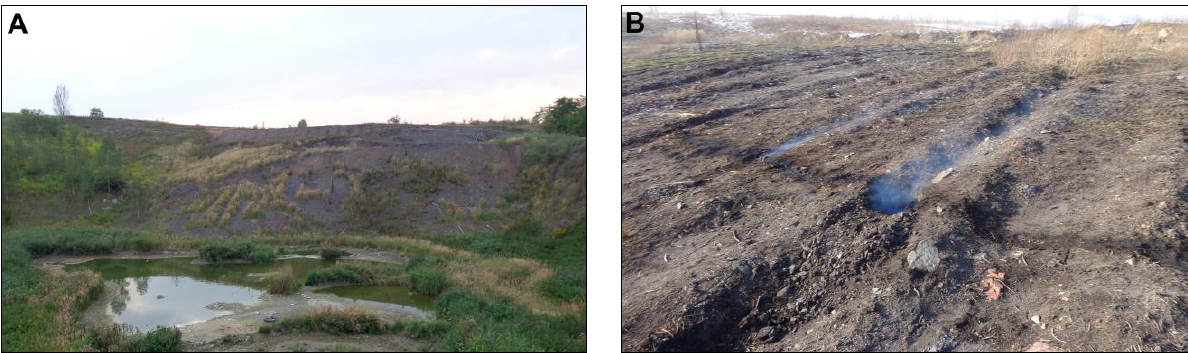
Fig. 2. A view of the "Wojkowice" spoil tip: A – August 2017; B – February 2017 ( A. Zarychta